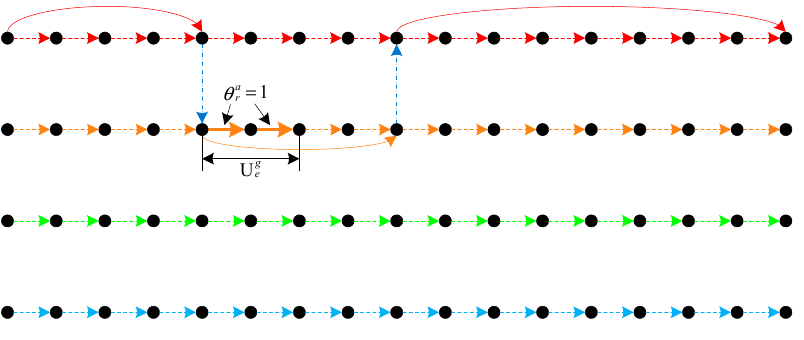
Figure 5. The interval of accepting train-sets for workshop.